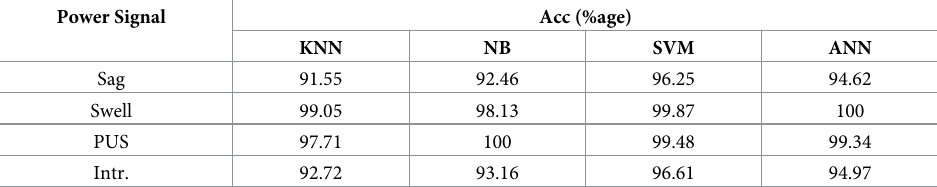
Table 2. Accuracy scores for power signals recognition, obtained by different classifiers.